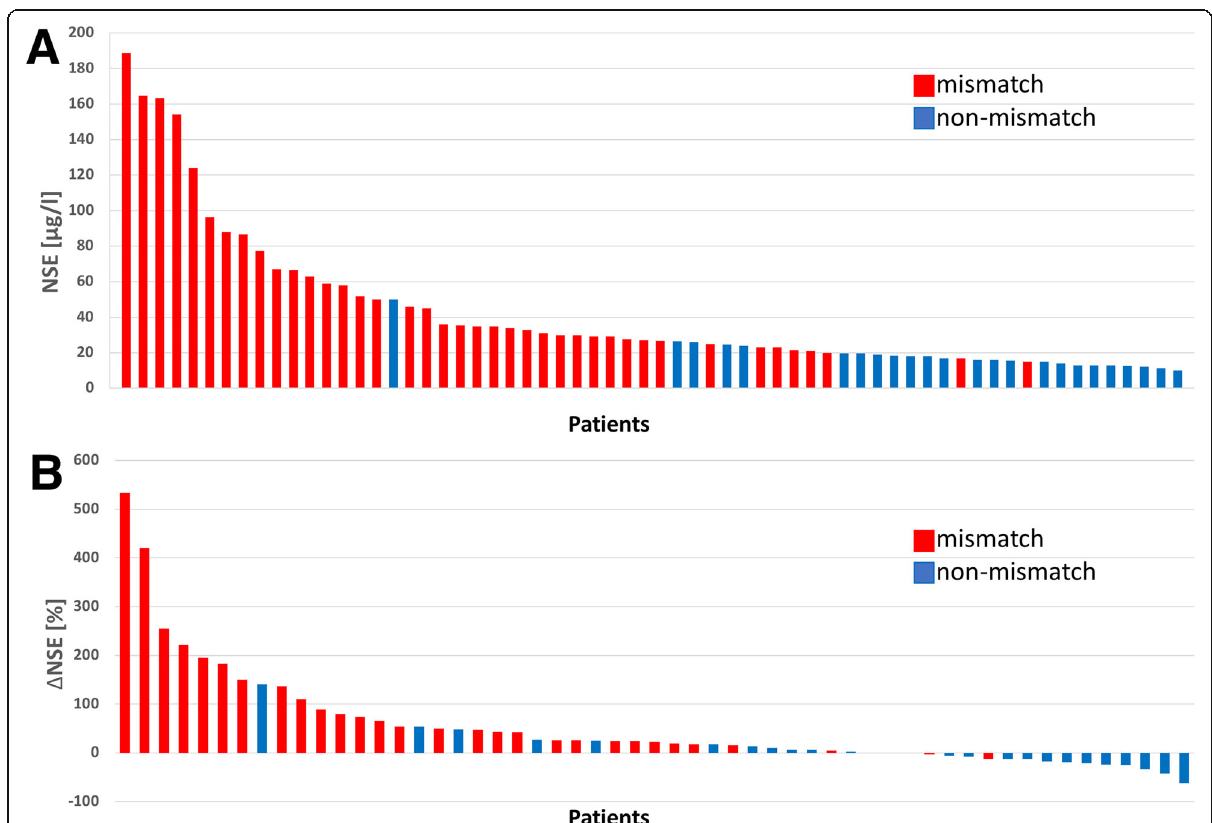
Fig. 4 Waterfall plot of NSE ( a ) and Δ NSE ( b ) values in descending order and color coding into mismatch (red) and a non-mismatch (blue)